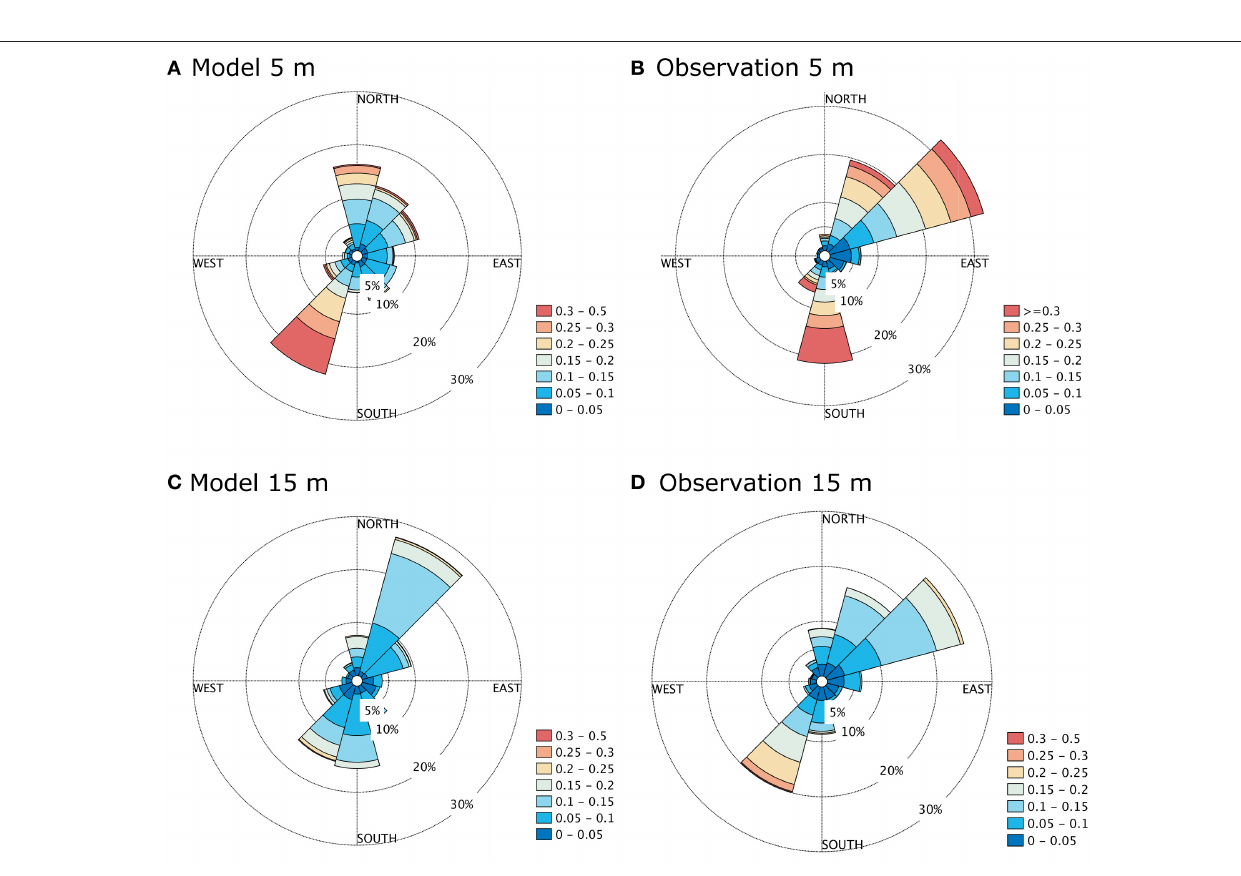
Frontiers in Marine Science | www.frontiersin.org